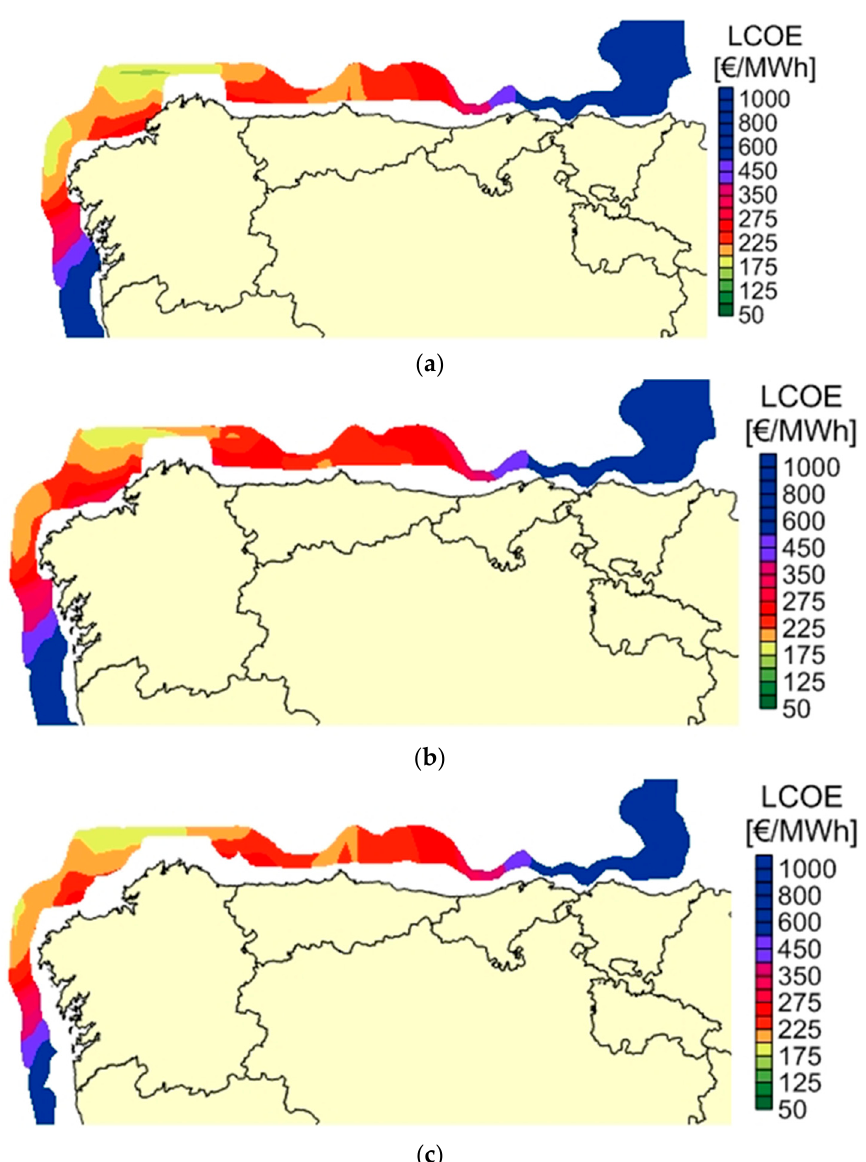
Figure 11. Results for levelized cost of energy (LCOE) with restrictions for semisubmersible ( a ), tension leg platform ( b ) and spar ( c ).